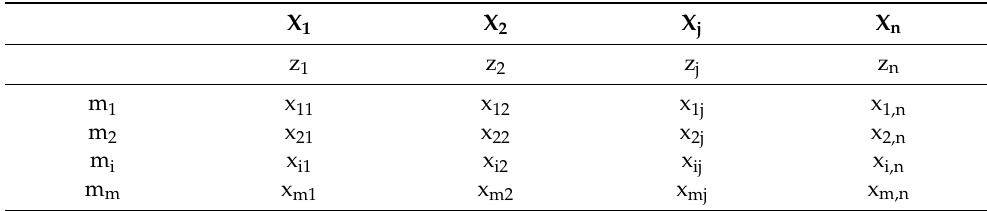
Table 3. TOPSIS decision